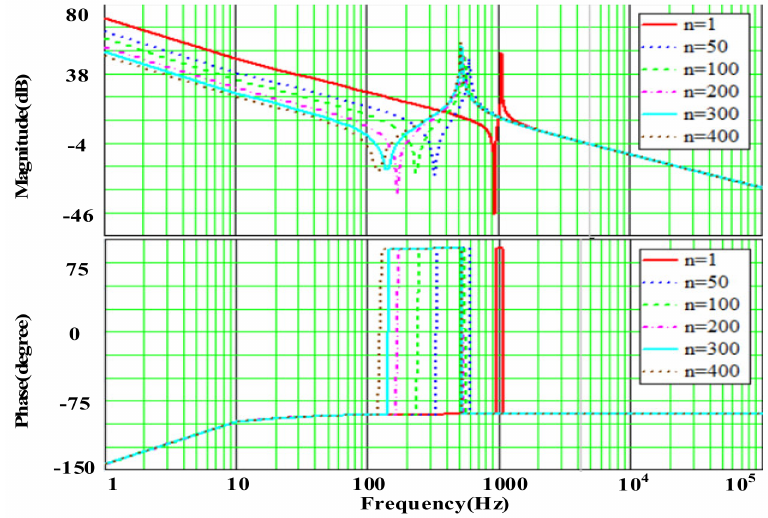
Figure 7. Open-loop Bode plot of multiple inverters.